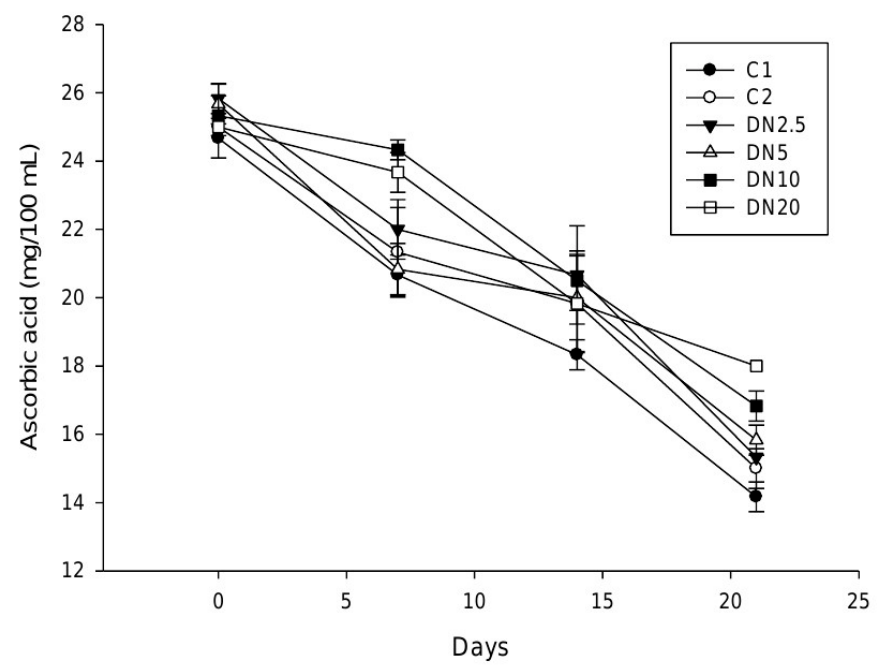
Figure 3. Vitamin C content in tomato fruits coated with nanoemulsion during storage at 6 °C. Regarding the quantification of the total phenols (Table 3), significant differences ( p Table 3. Quantification of bioactive compounds and antioxidant capacity in tomato fruits during < 0.05) were observed in all the treatment groups. The phenol concentrations of DN2.5 and DN20 (238.80 ± 8.33 and 251.45 ± 5.43 mg GAE/100 g, respectively) were higher on